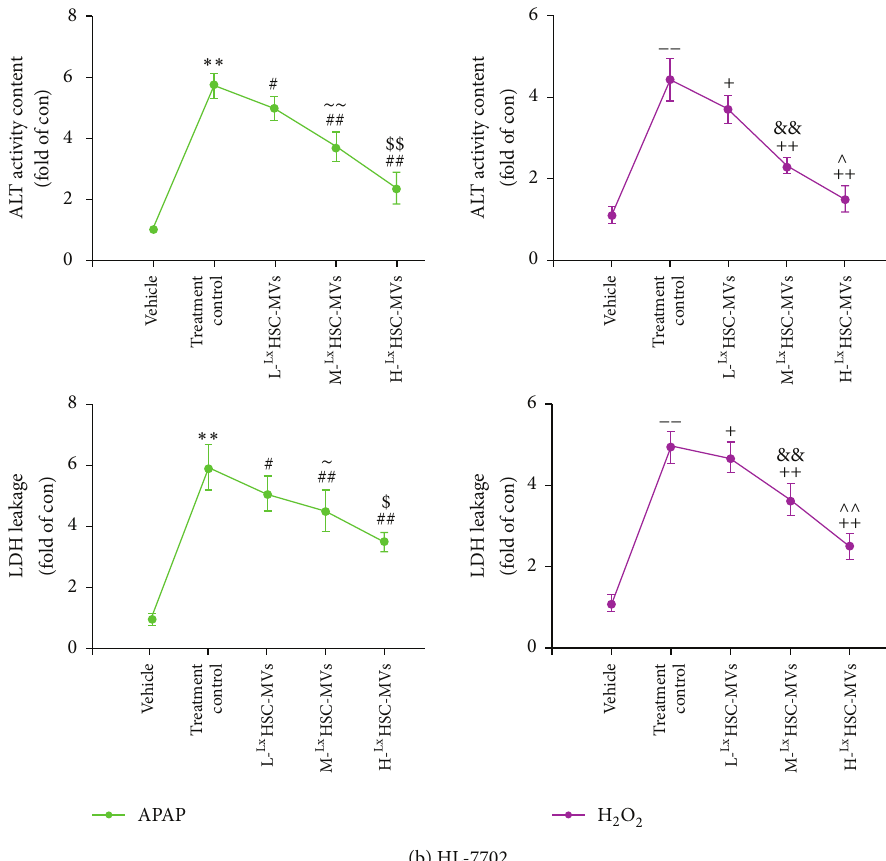
Figure 4: Effect of HSC-MVs on AST, ALT, and LDH leakage of APAP or H 2 O 2 -treated BRL-3A and HL-7702. (a) AST, ALT, and LDH leakage of APAP or H 2 O 2 -treated BRL-3A cocultured with T6 HSC-MVs. (b) AST, ALT, and LDH leakage of APAP or H 2 O 2 -treated HL-7702 cocultured with Lx HSC-MVs. ∗∗ 𝑝 < 0.01 versus vehicle, APAP; −− 𝑝 < 0.01 versus vehicle, H 2 O 2 ; # 𝑝 < 0.05 , ## 𝑝 < 0.01 versus treatment control, APAP; + 𝑝 < 0.05 , ++ 𝑝 < 0.01 versus treatment control, H 2 O 2 ; ∼∼ 𝑝 < 0.01 versus L-HSC-MVs, APAP; & 𝑝 < 0.05 , && 𝑝 < 0.01 versus L-HSC-MVs, H 2 O 2 ; $ 𝑝 < 0.05 , $$ 𝑝 < 0.01 versus M-HSC-MVs, APAP; ∧ 𝑝 < 0.05 , ∧∧ 𝑝 < 0.01 vs M-HSC-MVs, H 2 O 2 ; 𝑛 = 3 /group; ∼ represents 𝑝 < 0.05 versus L-HSC-MVs,